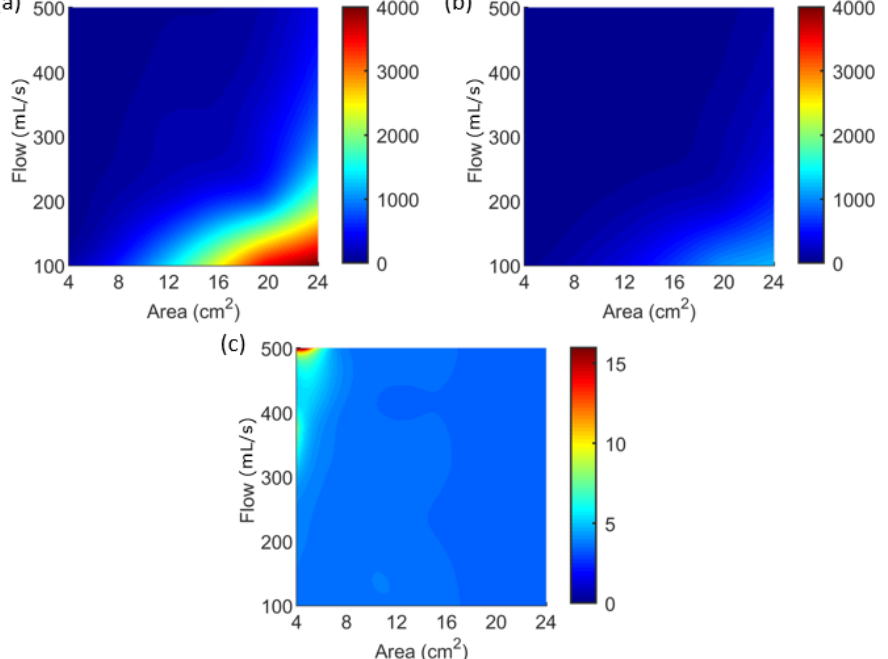
Figure 7. ( a ) Resulting γ | Ao trend as a function of flow and area; ( b ) Resulting γ | PA trend as a function of flow and area; ( c ) Trend of the ratio γ | Ao : γ | PA to changes in flow and